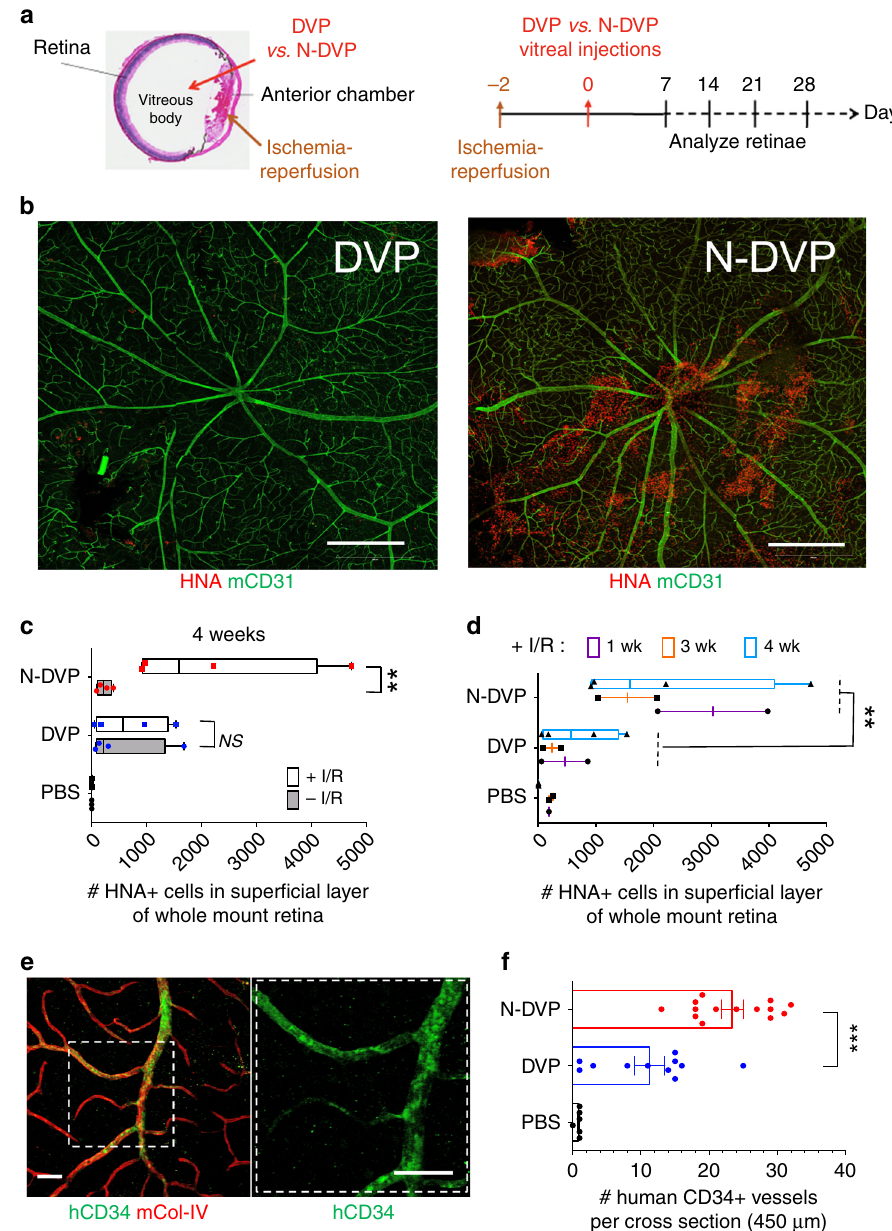
Fig. 6 Survival and vascular engraftment of primed vs. naïve DVP in I/R-injured murine retinae. a Schematic of NOG mouse ocular I/R experimental system for testing in vivo functionality of human primed DVP vs. N-DVP (modi fi ed from Park et al., 2014 7 ). (left) Anatomical structures where I/R (anterior chamber) and human DVP and N-DVP cell injections (vitreous body) were performed (left panel). (right) Timeline for I/R injury surgery, human DVP injections (Day 0), human cell survival and engraftment analysis. b Human DVP survival at the super fi cial layer of murine retina at 3 weeks following injection of 50,000 DVP or N-DVP into the vitreous of I/R-treated NOG mouse eyes. Flat whole-mounted retinae were stained with antibodies for human- speci fi c HNA (red), and tile scanned by confocal microscopic imaging (10x objective, 9 × 9 tiles). Shown are representative whole retinal images with HNA + cells from primed DVP cell-injected (left panel) vs. N-DVP cell-injected (right panel) eyes. Scale bars = 500 μ m. c Quantitation of HNA + cells detected in the outer super fi cial layers of whole mount retinae following treatment of eyes with and without I/R, and injected with either primed DVP or N-DVP at ( c ) 4 weeks or ( d ) at 1, 3, and 4 weeks following DVP vs. N-DVP vs. control saline (PBS) injections, in eyes treated with and without I/R injury. Shown are the mean numbers from independent eye experiments of total HNA + cells counted with imaging software per super fi cial layer of each whole- mounted retinae (whole fi eld). ** p < 0.01 (Mann-Whitney tests). e , f Human vascular engraftment into murine vessels. Whole-mounted retinae of I/R-injured eyes 2 weeks following DVP vs. N-DVP vs. PBS injections were immunostained with human CD34 (hCD34) to detect human endothelial engraftment. Antibodies for murine collagen type-IV (mCol-IV) were also employed to detect murine blood vessel basement membrane, and murine CD31 (mCD31) to detect murine endothelium. f The number of CD34 + human-murine chimeric vessels per 450 μ m cross-section was quantitated via confocal microscopy and imaging software. Shown are results of independent measurements. *** p < 0.001 (unpaired t